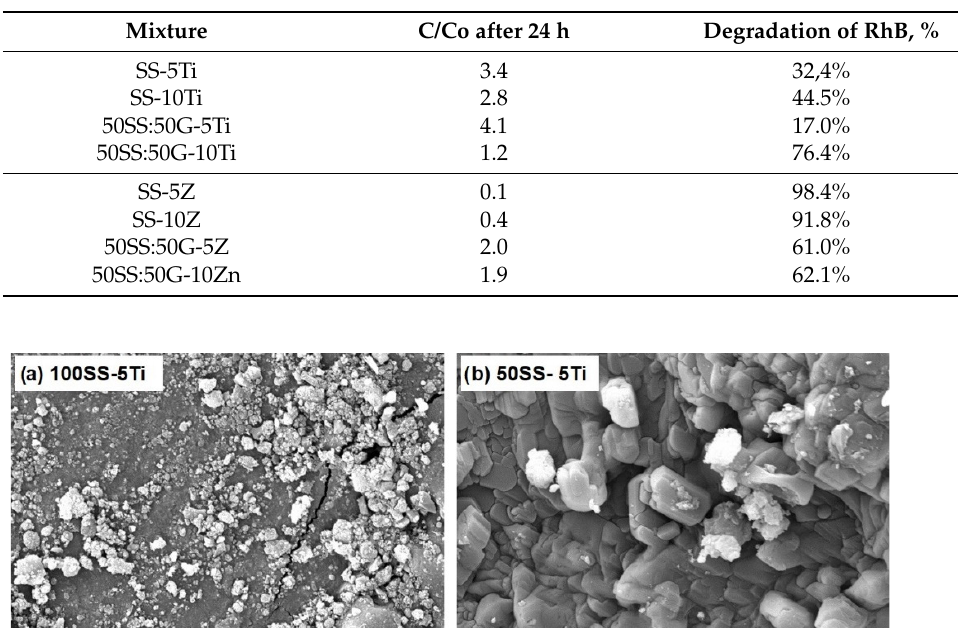
Figure 9. SEM images of composites with ( a , b ) 5% of TiO 2 and ( c , d ) 5% of ZnO.